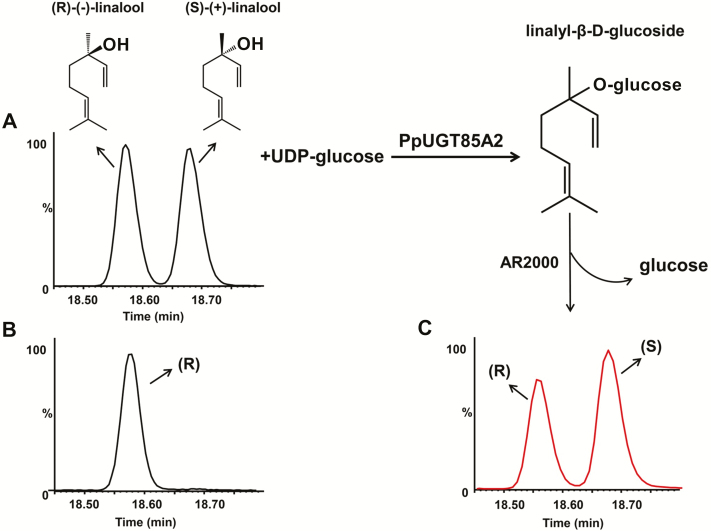
The enantiomeric preference of PpUGT85A2 towards linalool determined by chiral GC-MS analysis. (A) A racemic mixture (1:1) of R,S-linalool was used as a substrate. (B) Enantiomerically pure R-(–)-linalool was used as a reference material. (C) A slight enrichment of the S-(+)-linalool after hydrolysis of linalyl-β-d-glucoside by AR2000.